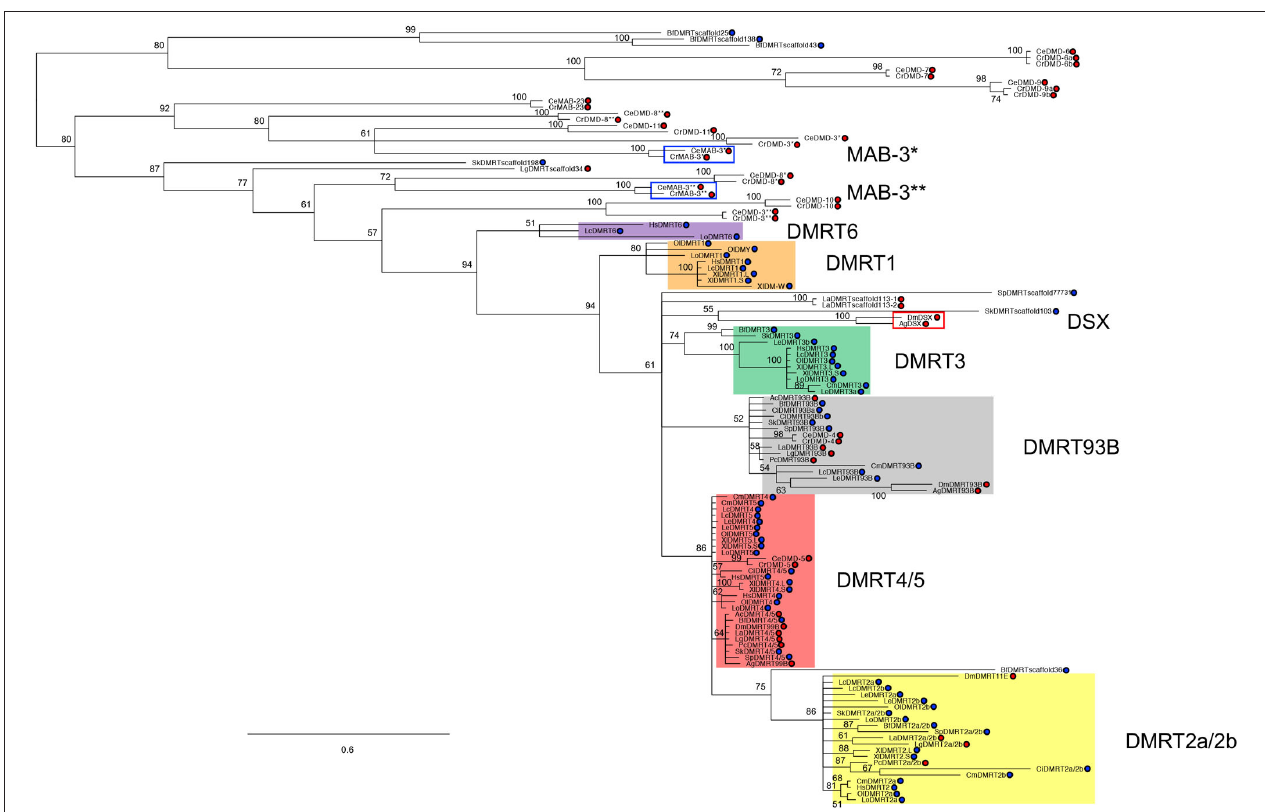
FIGURE 1 | DMRT family phylogeny. Figure adapted from Mawaribuchi et al. (2019). Bayesian tree of bilaterian Dmrt family genes. The tree was constructed using protein sequences of the DM domains from 19 species representing eight different phyla in bilateria. Blue and red circles represent Deuterostomia and Protostomia, respectively. * and ** indicate DM domain regions on 5 ′ and 3 ′ sides, respectively. Lingula anatina (La); Aplysia californica (Ac); L. gigantea (Lg); Priapulus caudatus (Pc); Caenorhabditis elegans (Ce); Caenorhabditis remanei (Cr); Anopheles gambiae (Ag); Drosophila melanogaster (Dm); Saccoglossus kowalevskii